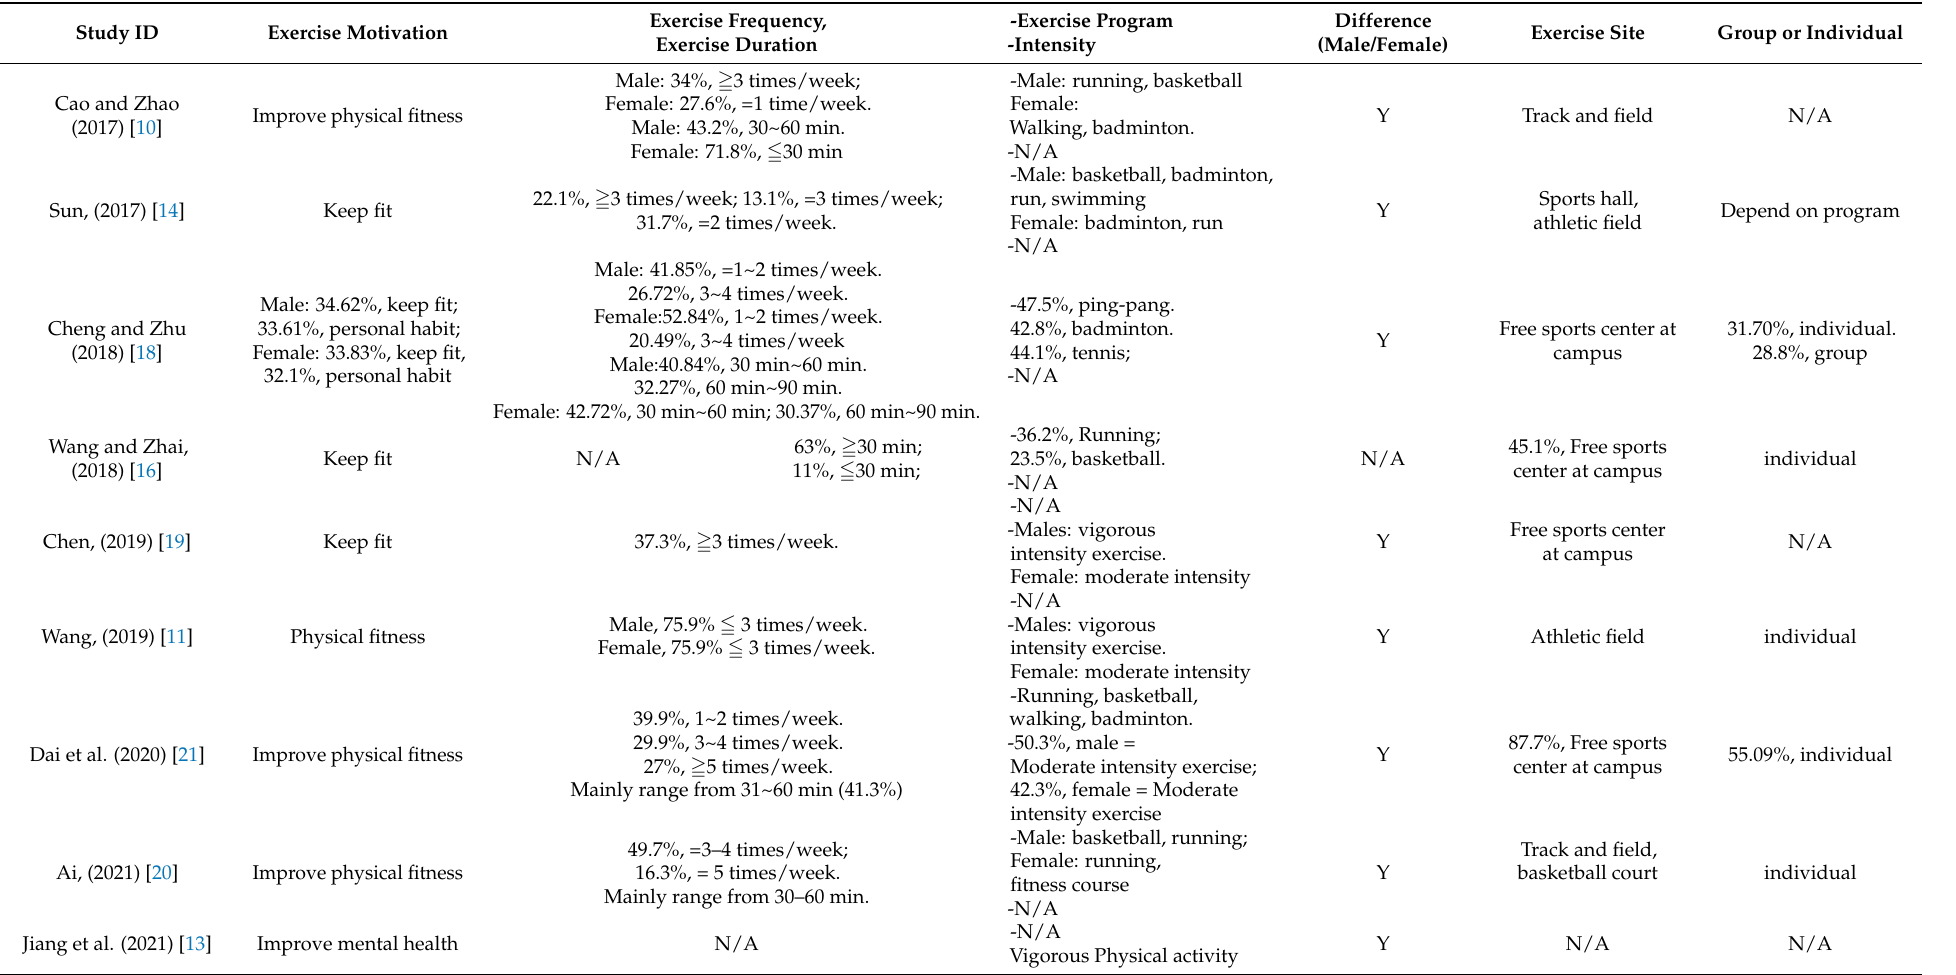
Table 2. Contents of the studied in